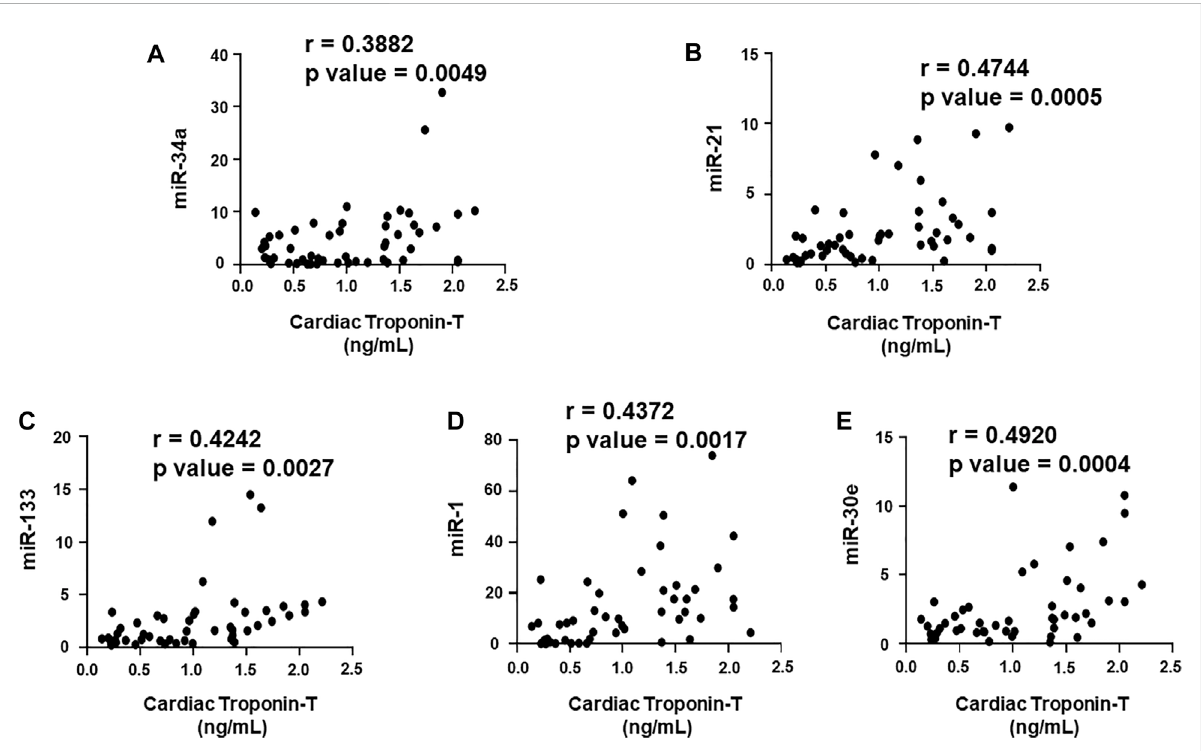
FIGURE 6 Correlation analysis of cardiac troponin T with circulating plasma miRNAs. Correlation analysis was performed using a scatter plot between cardiac troponin T and plasma miRNAs, (A) miR-34a, (B) miR-21, (C) miR-133, (D) miR-1, (E) miR-30e. Pearson ’ s r coef fi cient was used to determine the extent of correlation and statistical signi fi cance was obtained by two-tailed p -value. Each plot independently demonstrates the correlation (Pearson ’ s r coef fi cient) and signi fi cance ( p —